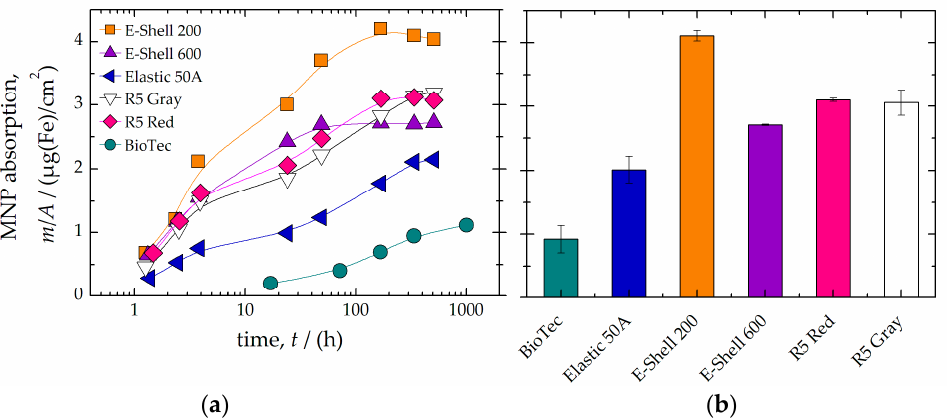
Figure 2. The time-dependent accumulation of MNP on the sample surface (shape cylinder) of different AM materials was quantified by MPS ( a ). Saturation value of absorbed MNP (MPI tracer) amount after 300 h for each AM material ( b ).